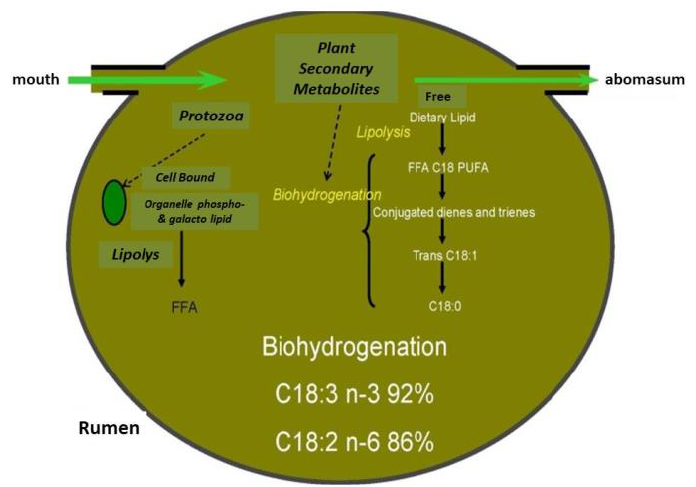
Figure 1. Diagrammatic representation of lipid metabolism in the rumen including the action of plant secondary metabolites [4].